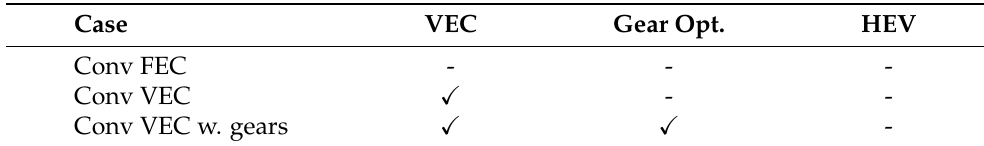
Table 3. Conventional vehicle cases considered.